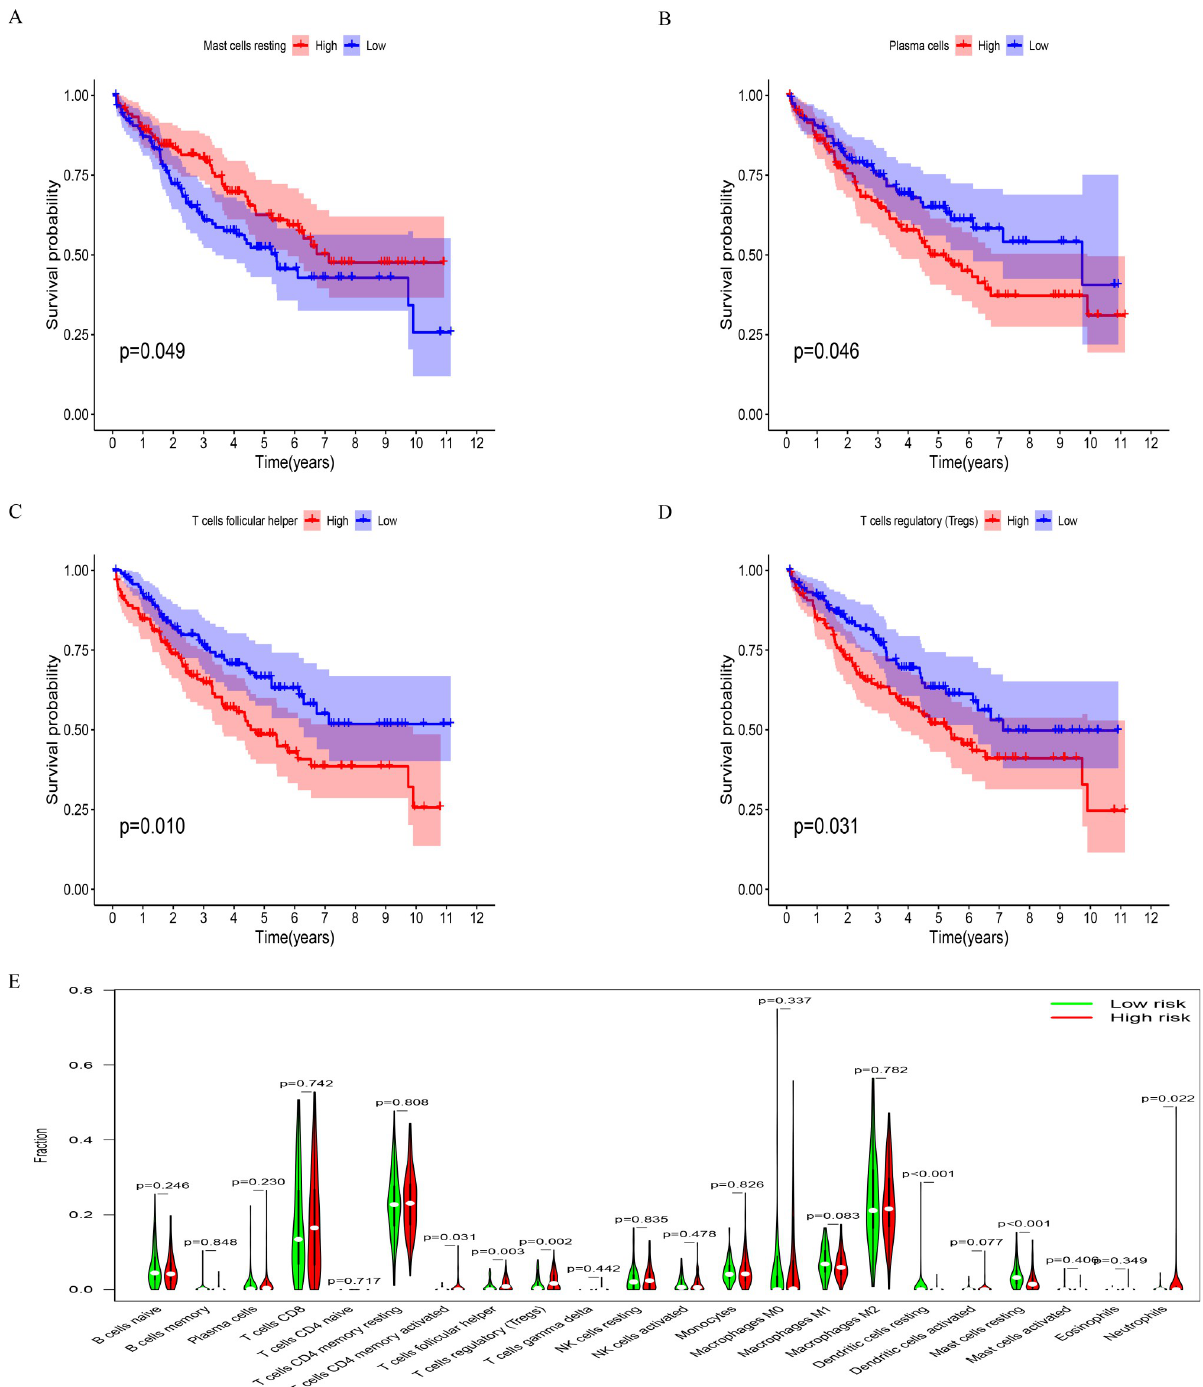
Fig 6. Comparison between two risk groups and the immune cell content and prognosis of immune cells. (A) difference analysis of immune cell content in the two risk groups. (B–E) Prognostic analysis of patients with a varying number of resting mast cells, plasma cells, follicular helper T cells, and regulatory T